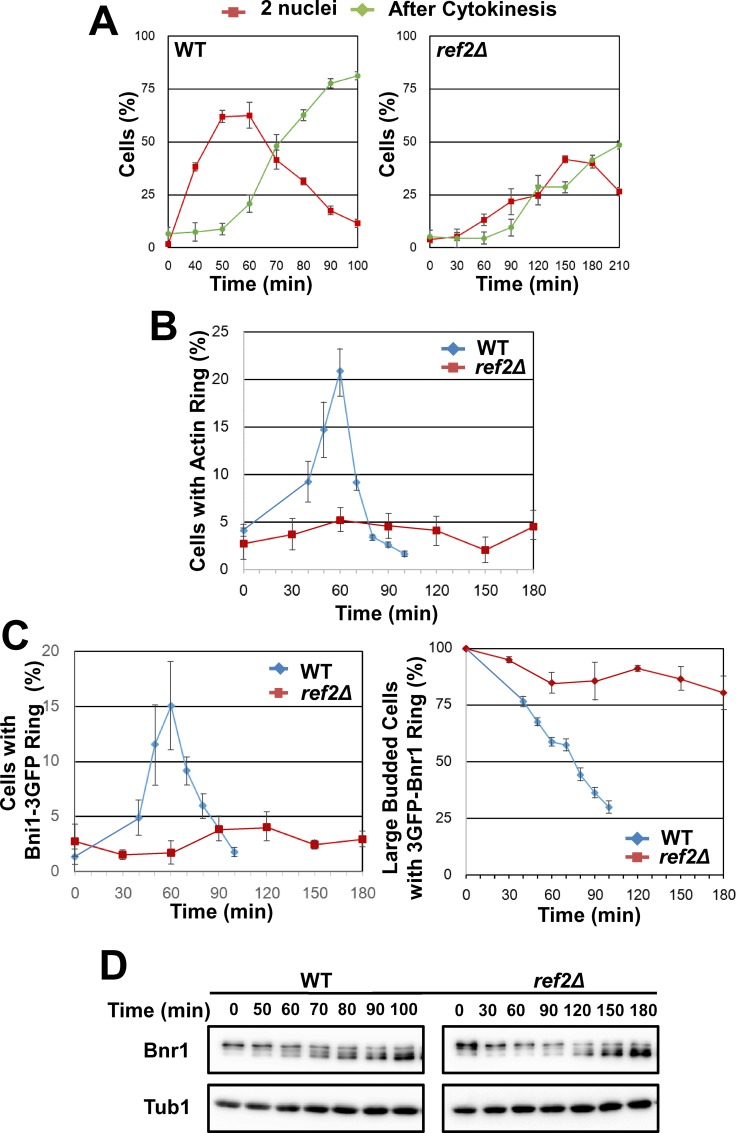
Ref2 is required for formin switching and actomyosin ring formation.A, ref2Δ cells and isogenic control cells were synchronized, released and analyzed as in Fig 3. Note that in this and subsequent figures, time points for the observation were not identical between ref2Δ and control cells, due to slow growth phenotype of ref2Δ cells. N>100 for each experiment. Means of three independent experiments were shown. Error bars, s.e.m. B, ref2Δ cells and isogenic control cells were synchronized, released and analyzed as in Fig 3. N>100 for each experiment. Means of three independent experiments were shown. Error bars, s.e.m. C, ref2Δ cells expressing BNI1-3GFP or 3GFP-BNR1 from own promoters were synchronized, released and analyzed as in Fig 3. N>100 for each experiment. Means of three independent experiments were shown. Error bars, s.e.m. D, ref2Δ cells expressing Bnr1-13myc were synchronized, released and analyzed as in Fig 2A.